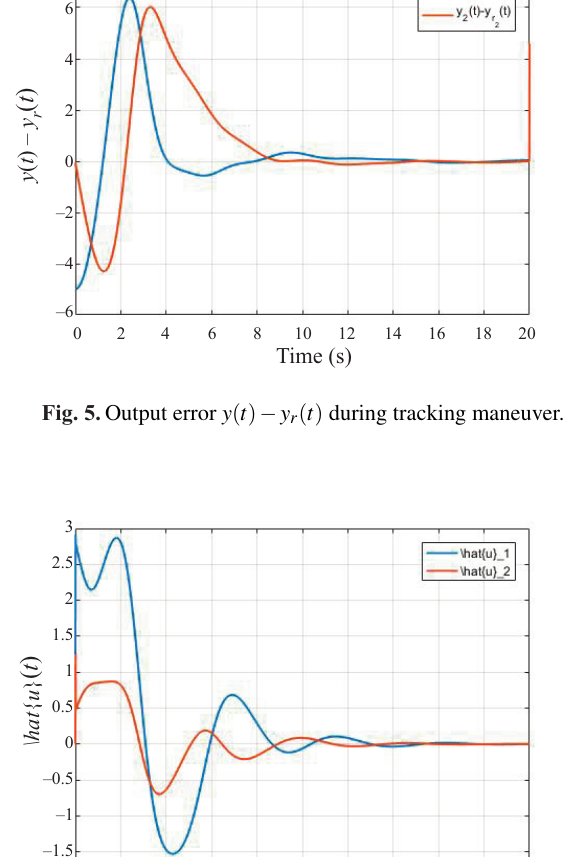
Figure 6. Control input ˆ u during tracking